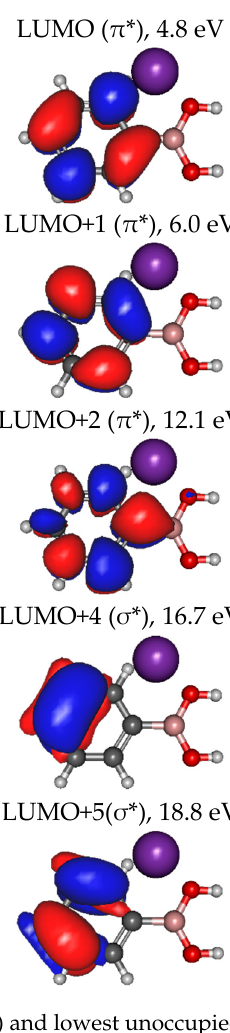
Figure 8. Calculated highest occupied molecular orbital (HOMO) and lowest unoccupied molecular orbitals (LUMOs) for phenylboronic acid (PBA). Orbitals were calculated at the CASSCF (5,10) level of theory in the presence of a potassium atom (in purple color) at a distance of 10 Å.